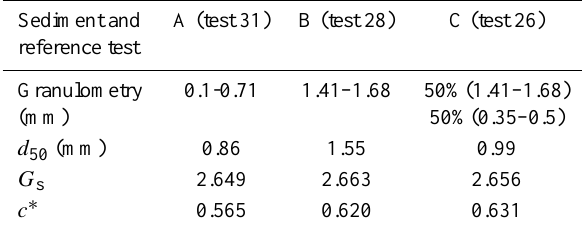
Table 1. Properties of sediments and embankments: for the three sediments (indicated as A, B, C) are shown the different granulom- Figure 4. Sketch of the flume in the experiment. Water flows from right to left. etry, the mean diameter, d 50 , and the specific gravity G s . For the different embankments are collected the mean dry volumetric con- centrations, c ∗ .